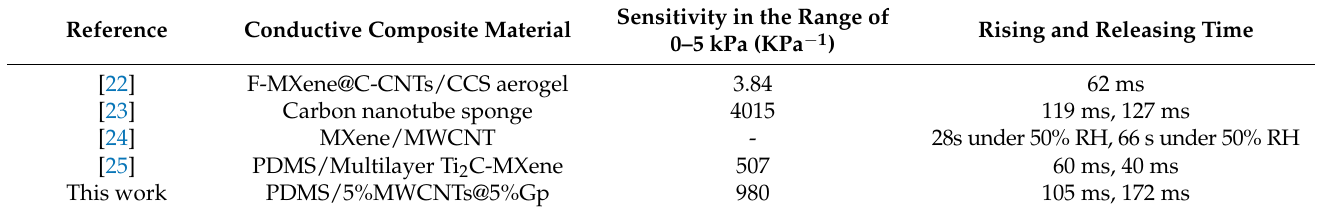
Table 2. Comparisons with other reported piezoresistive sensors.